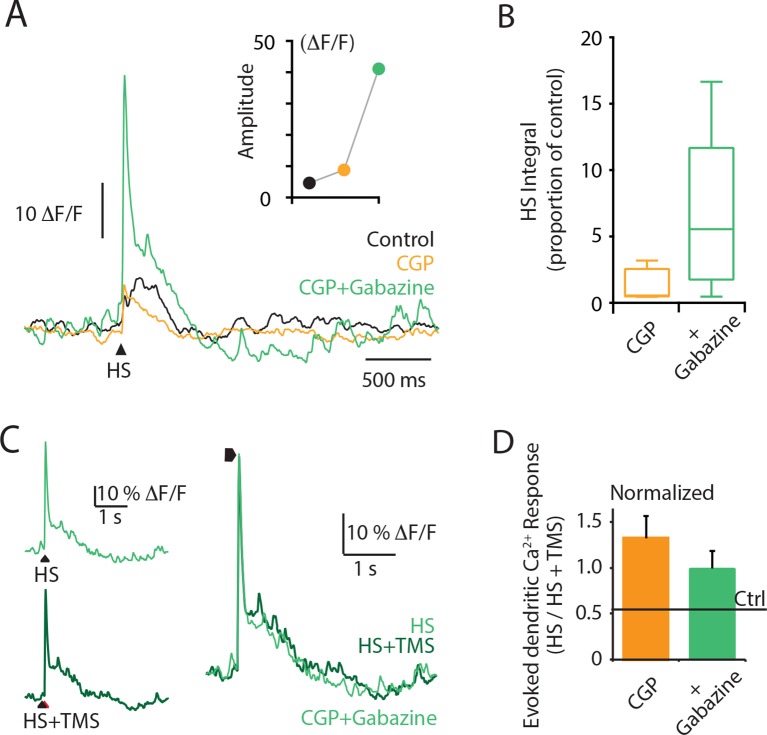
Cortical application of the GABAA antagonist Gabazine causes a dramatic increase in the dendritic response to hindpaw stimulation.Layer 5 (L5) pyramidal neurons were bulk loaded with the Ca2+ indicator OGB1 AM, and the evoked Ca2+ response was recorded using a fiber optic. (A) An example L5 dendritic Ca2+ response to hindpaw stimulation (HS) during control (black), CGP (orange) and CGP+Gabazine (green) cortical application. (B) Integral of the HS-evoked Ca2+ response as a proportion of the control response during cortical application of CGP+gabazine (green) and CGP (orange). (C) An example L5 dendritic Ca2+ response to hindpaw stimulation (HS, light green) and hindpaw stimulation during TMS (HS+TMS, dark green) during CGP+Gabazine cortical application. Individual traces are overlaid on right. (D) Evoked dendritic Ca2+ response during TMS (HS+TMS) normalized to HS alone during CGP (orange) and CGP + Gabazine (green). TMS, transcranial magnetic stimulation.